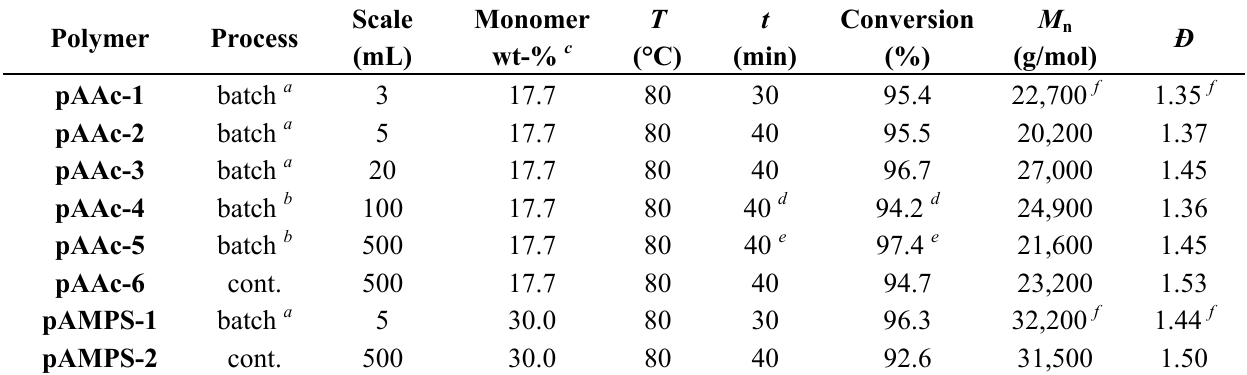
Table 1. Experimental conditions and results for RAFT polymerizations in batch and continuous